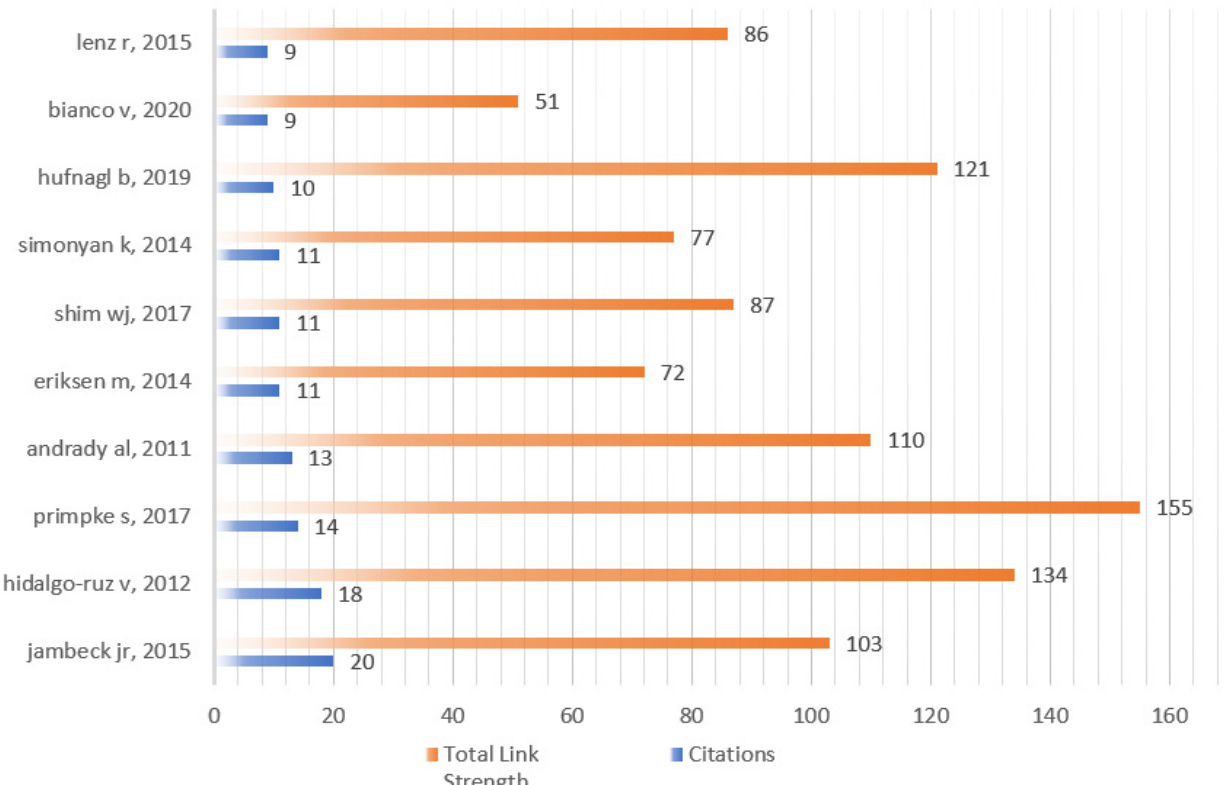
Figure 22. The most co-citation references from 2018 to 2022.